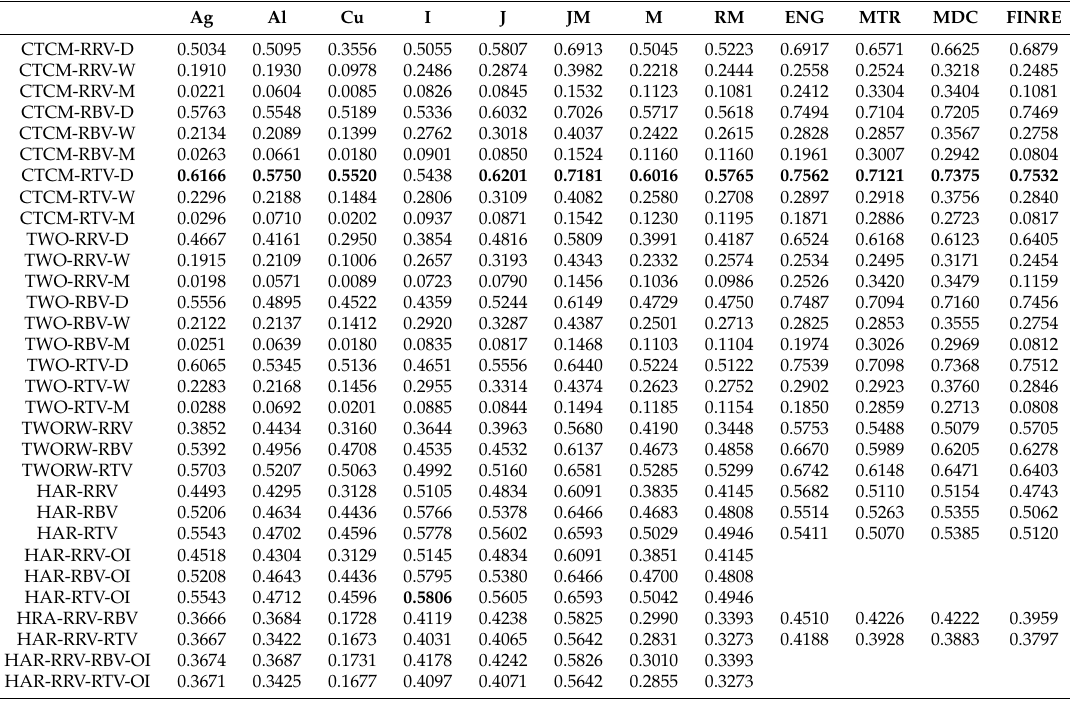
Table 4. The results of